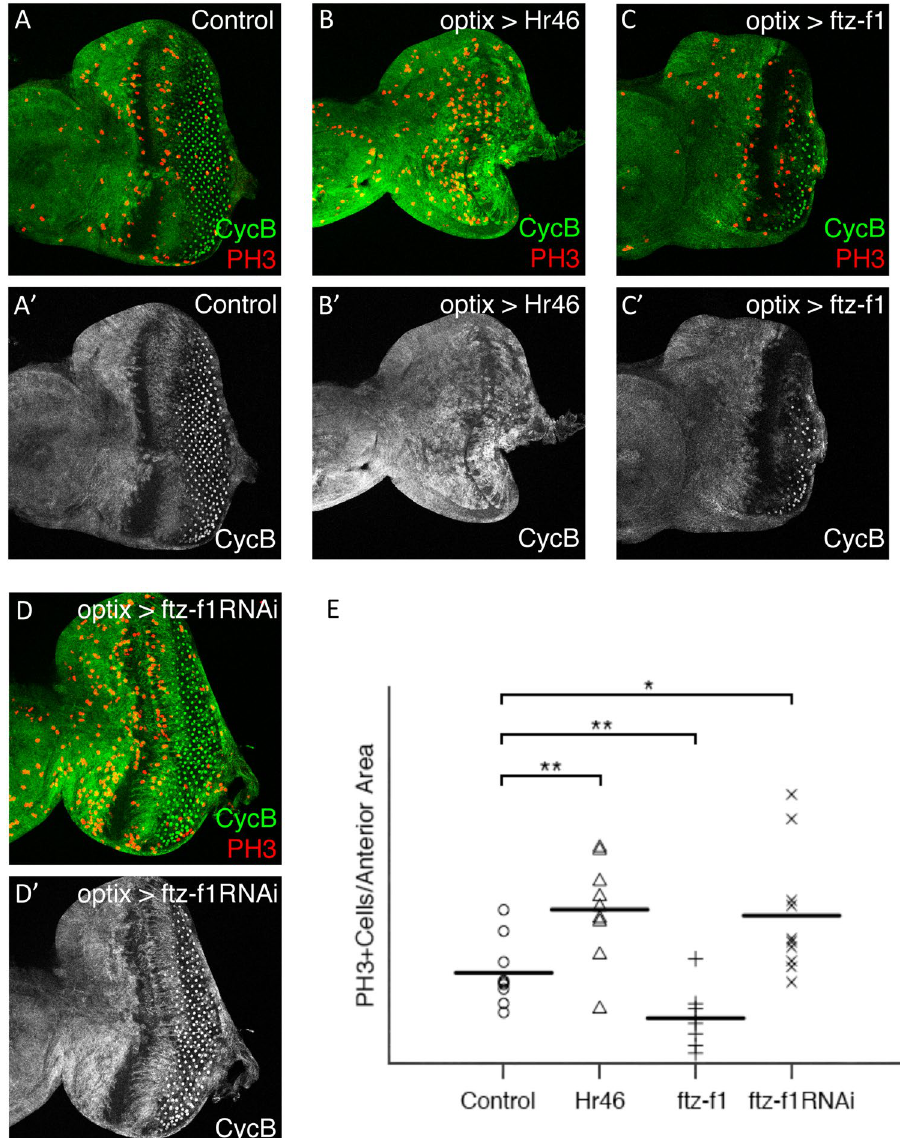
Figure 7. Altering Hr46 and ftz - f1 expression regulates proliferation of eye progenitors. L3 eye discs of the indicated genotypes ( A – D ) stained for cyclinB (cycB, green) and the mitotic marker PH3 (red). Merged and cycB signals are shown. Control discs are optix >+ . PH3-positive cells were counted in the anterior region of the eye disc, where undifferentiated progenitors reside (outlined in white in A ). In ( A’ ) the double-headed arrow marks the width of the G1-arrested domain (see text for details). ( E ) Statistical analysis of the mitotic density (PH3 + cells/anterior area) indicates that overexpression of Hr46 and RNAi-mediated attenuation of ftz - f1 result in increased proliferation. Note that in both genotypes the G1 arrested domain is narrower than in the control (especially for optix > Hr46 ; B ). On the contrary, overexpression of ftz - f1 results in reduced